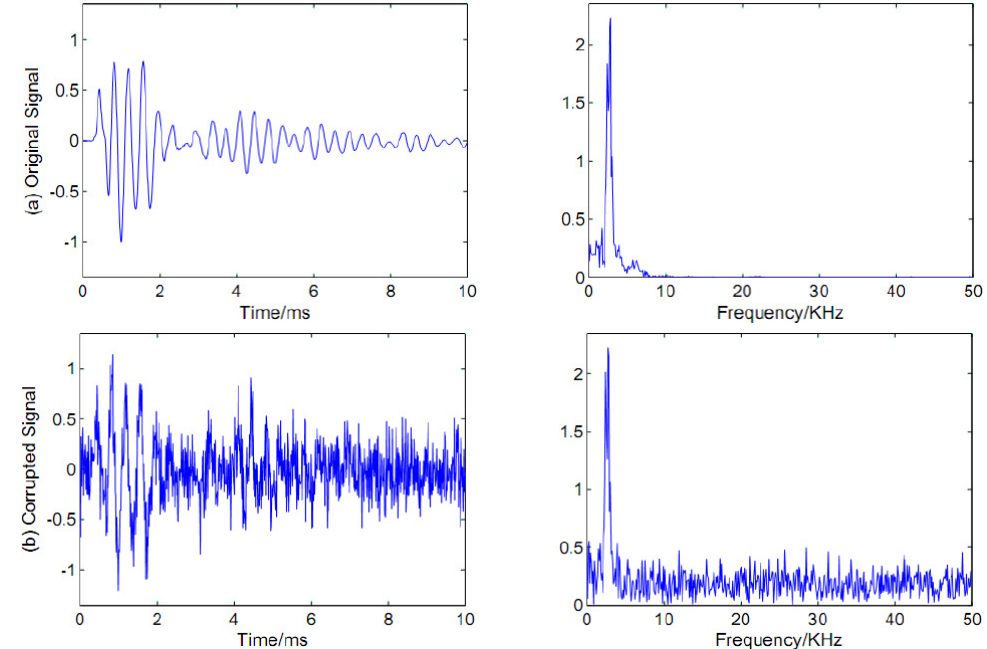
Figure 4. A typical stress wave signal and its corrupted version. From top to